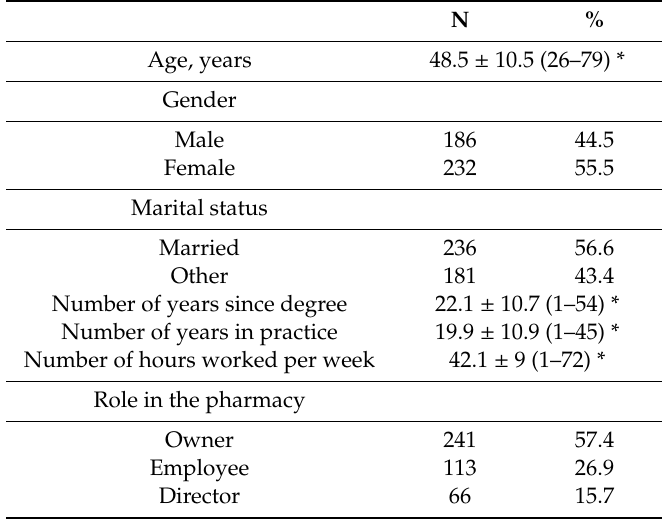
Table 1. Socio-demographic and professional characteristics of the study